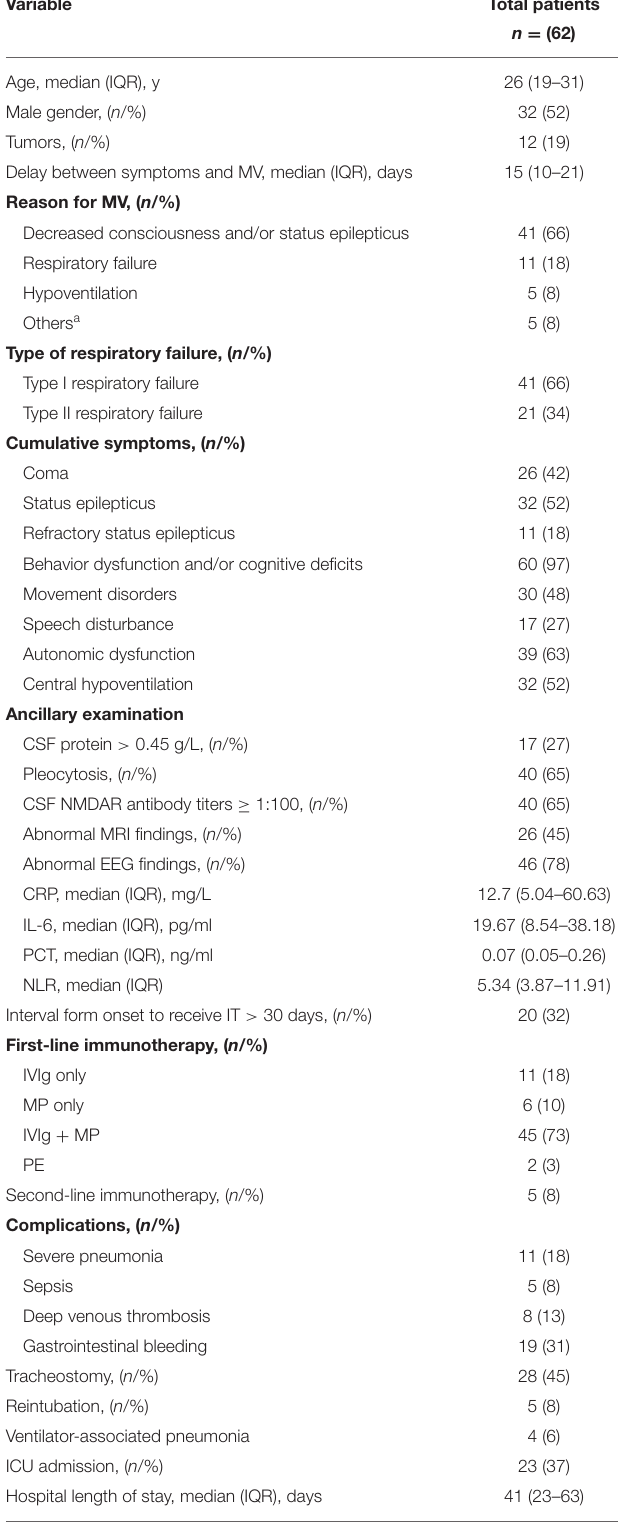
TABLE 1 | Baseline characteristics of the study